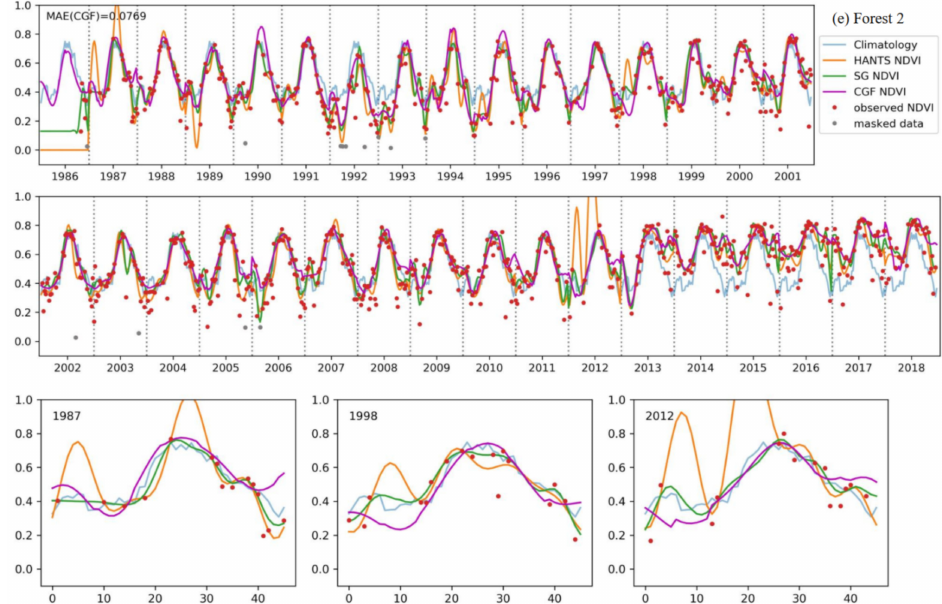
Figure 10. The performance of the NDVI prediction model over different vegetation types (( a – e ) represent different samples of different vegetation types) for long time series. Specific cases with significant difference in some years are highlighted for each vegetation type.